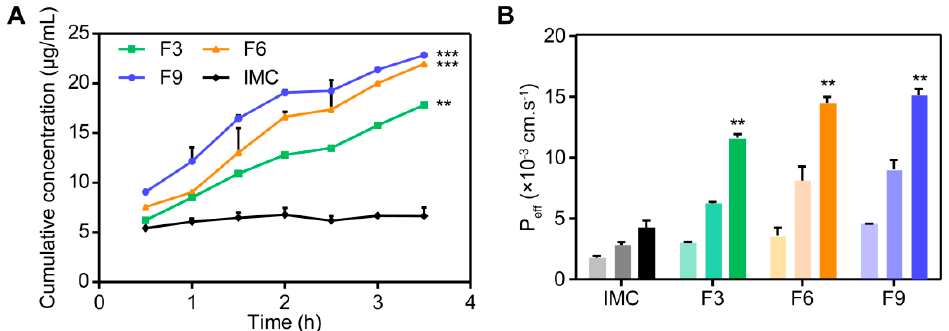
Figure 7. ( A ) Permeation profile of pure IMC and IMC–SDs in parallel artificial membrane permeability assay (PAMPA) experiment (mean ± SD, n = 3). ( B ) Permeation effective of IMC and IMC–SDs at 1.5 h, 2.5 h, and 3.5 h with the color becoming darker, respectively (mean ± SD, n = 3). ** p < 0.01, and *** p < 0.001 compared to the IMC group.